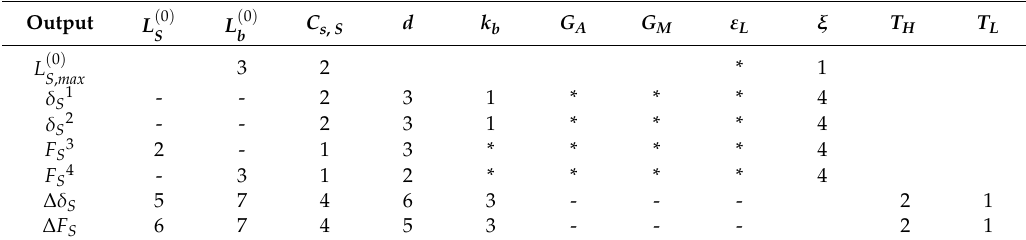
Table 7. Evaluation of parametric impact with contribution